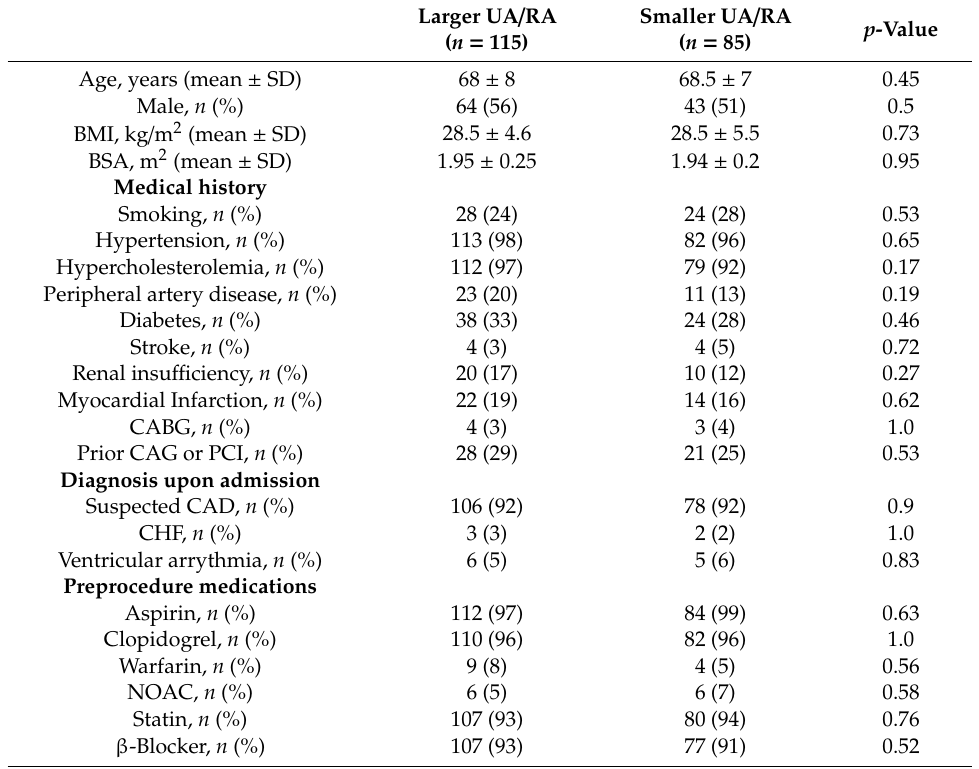
Table 1. Demographic and baseline characteristics of the